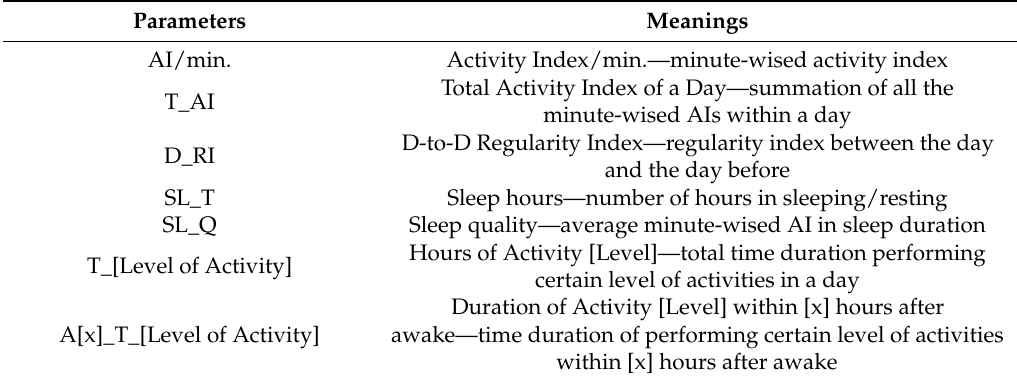
Table 3. Parameters used for activity-based